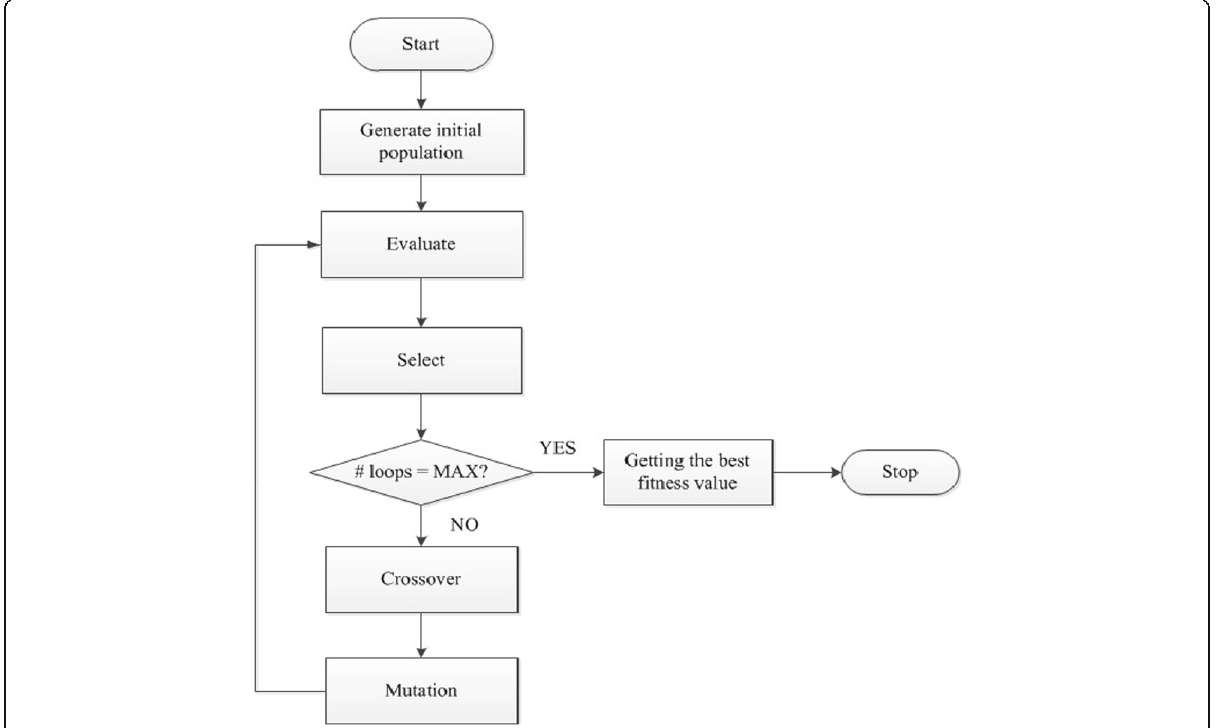
Fig. 1 Flowchart of the genetic